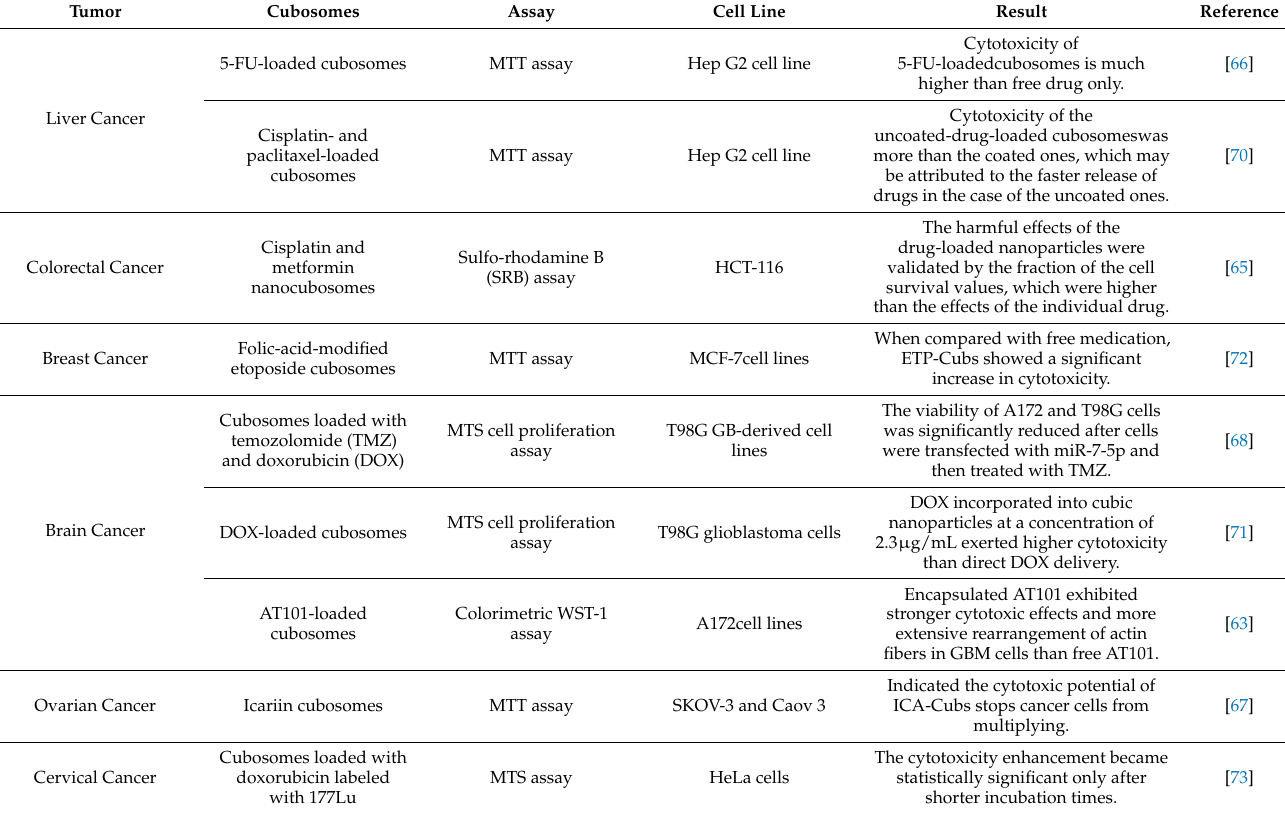
Table 4. In vitro cytotoxicity of anticancer